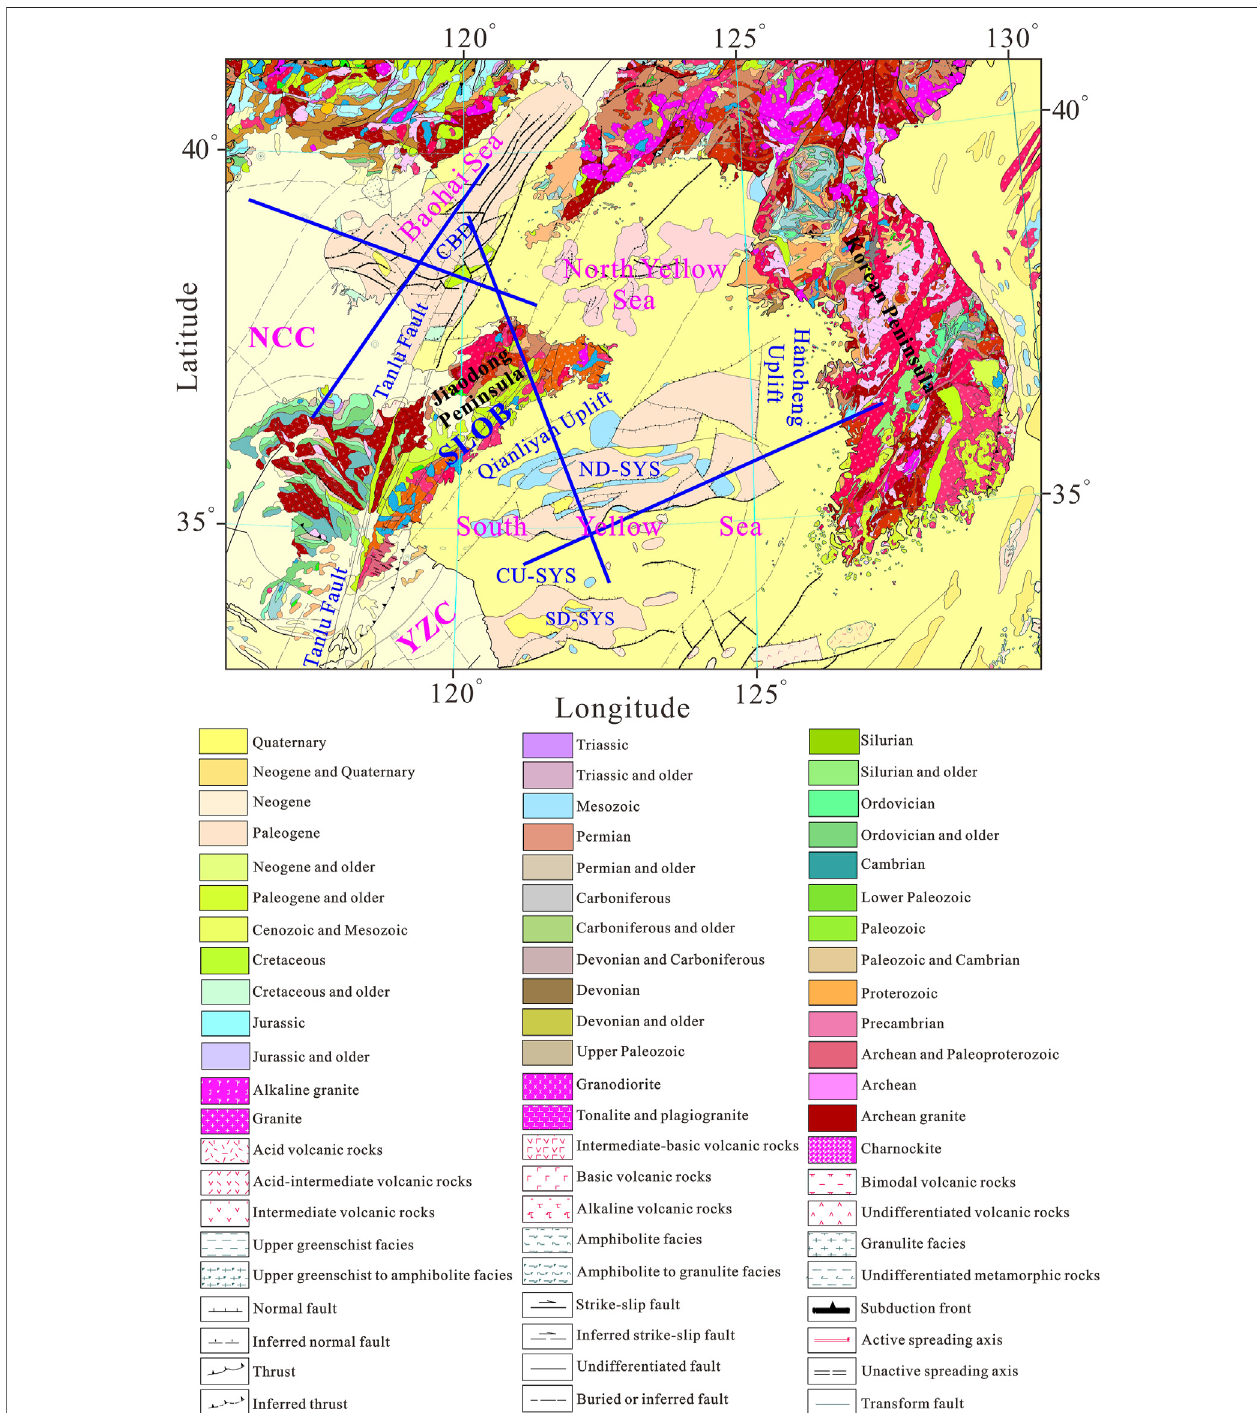
FIGURE 2 | Geological map of the study area (after Wang et al. (2017), and has the same legend as their results). The blue lines are the locations of wide-angle seismic pro fi les as shown in Figure 1 . The offshore tectonic units involved include: Central Bohai Depression (CBD), Qianliyan Uplift, Northern Depression of SYS (ND- SYS),CentralUpliftofSYS(CU-SYS),andSouthernDepressionofSYS(SD-SYS).Thegeologicalmapcanbeaccessedvia:http://dcc.ngac.org.cn/geologicalData/rest/ geologicalData/geologicalDataDetail/402881f75d9bbbed015d9bbbfa280000.